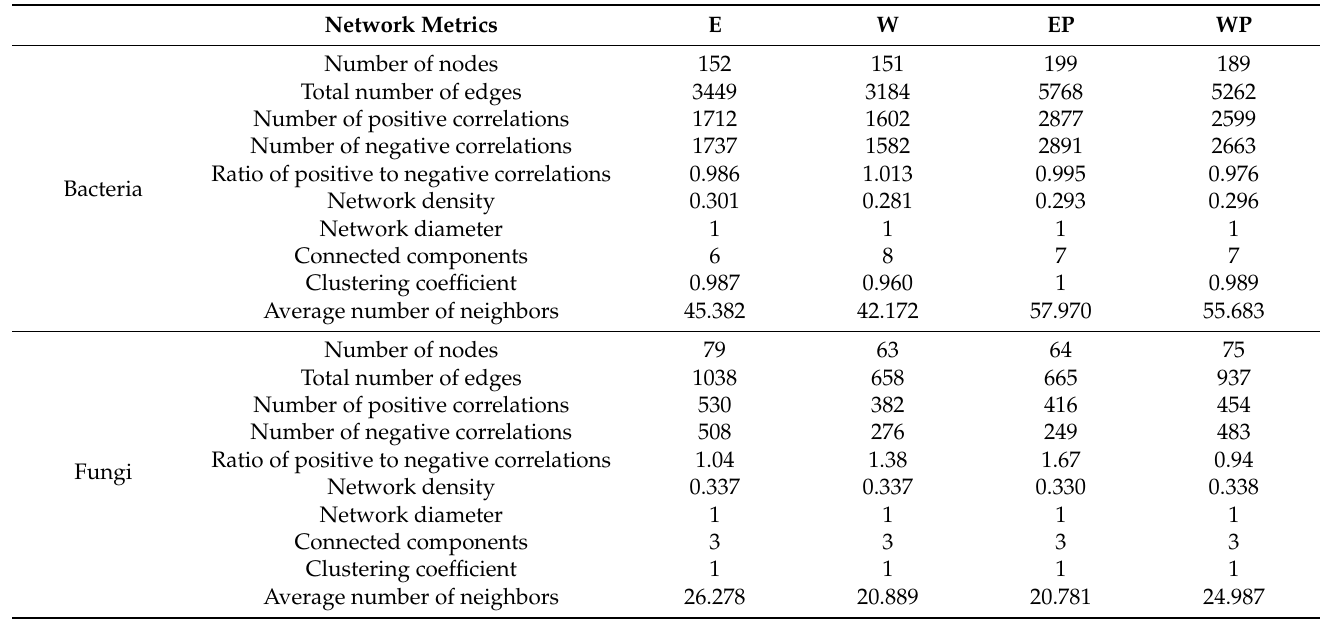
Table 4. Topological properties of co-occurring bacterial and fungal networks in soil samples from applying peanut root exudates or distilled